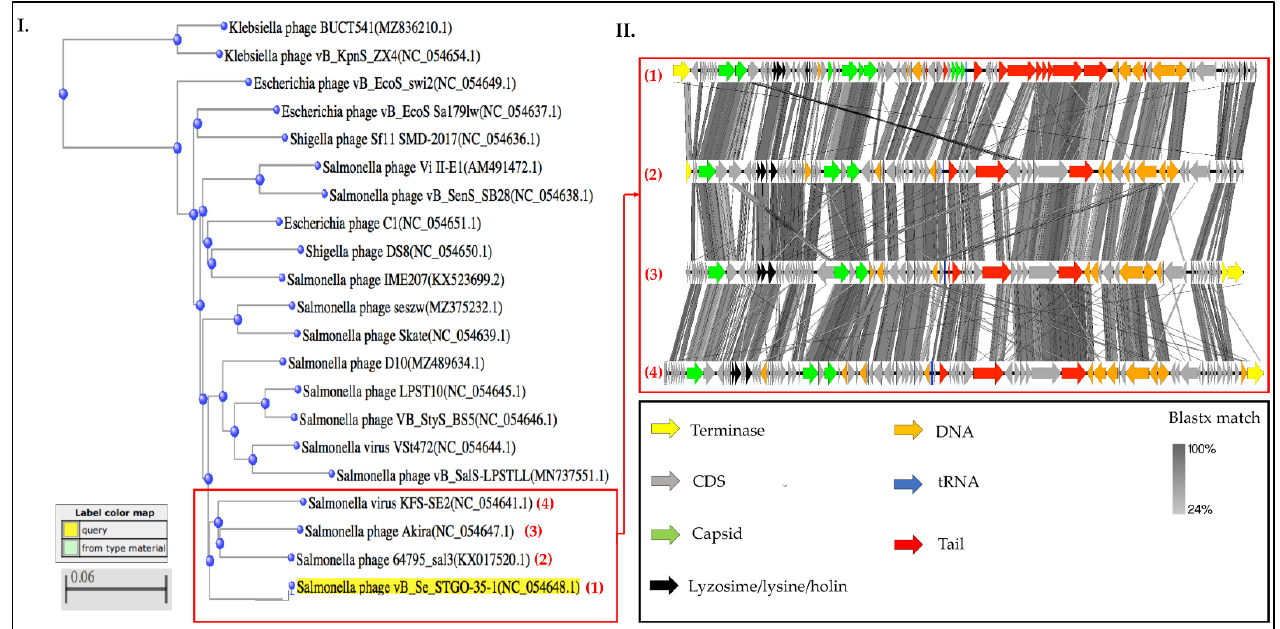
Figure 4. Phylogenetic relatedness of STGO-35-1 to other siphoviral morphotypes of phages. I. Phy- logenetic tree based on COBALT [56], using neighbor joining [55]. Phage most closely related to STGO-35-1 in red squares were marked. II. Comparison of Salmonella phage STGO 35-1 (1) with the three most closely related phages: Salmonella phage KFS-SE2 (4), Salmonella phage Akira (3), and Salmonella 6795_sal3 (2). The color coding of genes indicates putative functional categories: capsid proteins (green); lysozyme (black); CDSs and hypothetical proteins (gray); tail proteins (red).